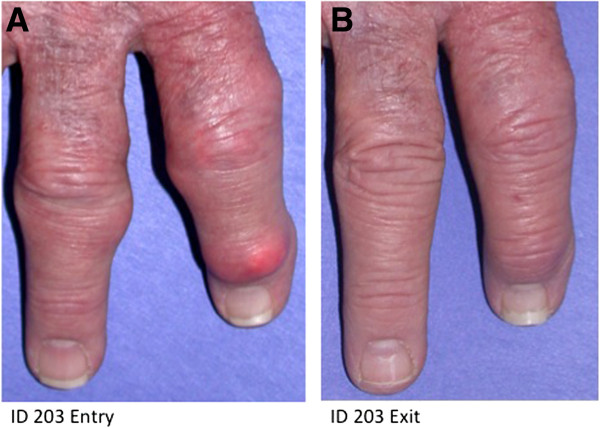
Resolution of digital tophi in a persistent responder. (A). Prior to treatment with five doses of pegloticase, 8 mg, infused at three-week intervals. (B). At follow-up visit.